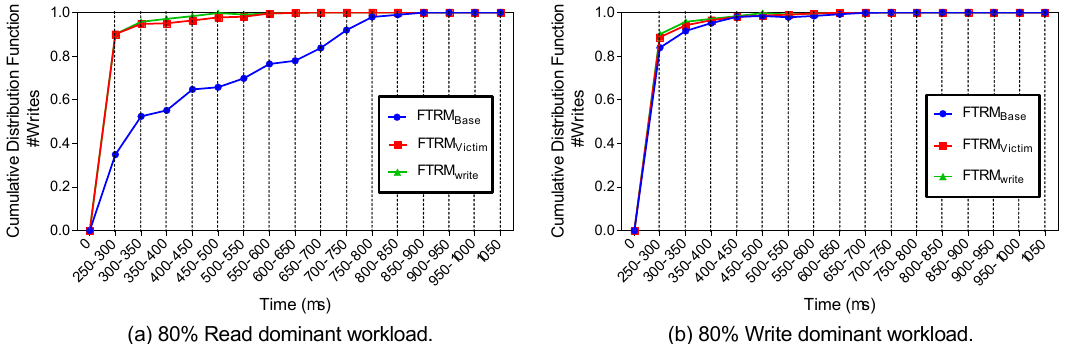
Figure 5. Comparison of Cumulative Distribution Function (CDF) for Mapping Writes I/Os between FTRM